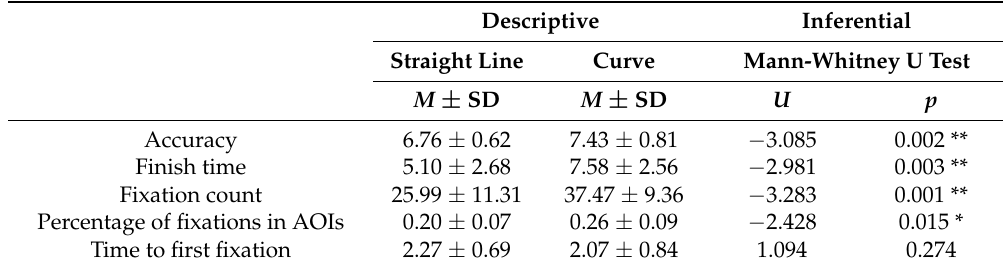
Table 3. Descriptive statistics for the different linear features.